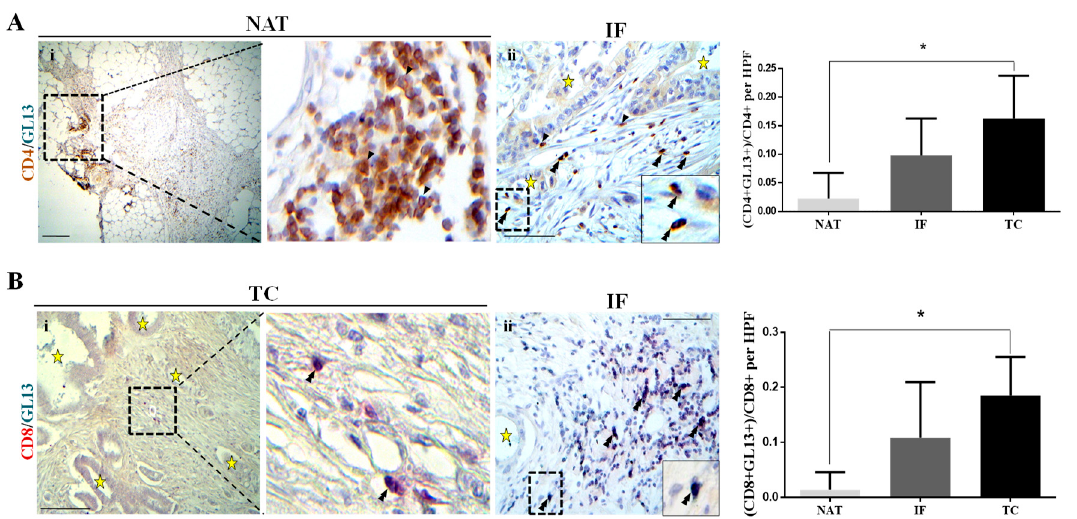
Figure 4. T lymphocytes in PDAC exhibit a senescent phenotype. ( A ) Co-expression of CD4 (brown) and GL13 (emerald) assessed by double immunohistochemistry analysis. Left panel: representative micrograph showing CD4 single positive (single arrows) in the normal parenchyma adjacent to the tumor (NAT) ( i , scale bar: 200 µ m). Insert indicates higher magnification. CD4 and GL13 double positive cells (double arrowheads) in the tumor center (TC) ( ii , scale bar: 100 µ m). Asterisks depict cancer glands. Right panel: quantification of CD4 and GL13 double positive cells per high power field (HPF, 400 × magnification). * p -value < 0.05. Data are expressed as mean ± STDEV (N = 5). ( B ) Co-expression of CD8 (red) and GL13 (emerald) assessed by double immunohistochemistry analysis. Left panel: representative micrographs of the TC ( i ) and IF ( ii ), where double arrowheads depict CD8 and GL13 double positive cells. Asterisks denote cancer glands. Scale bar: 200 µ m (i); 100 µ m (ii). Insert depicts higher magnification. Right panel: quantification of the CD8 and GL13 double positive cells per high power field (HPF, 400 × magnification). * p -value < 0.05. Data are expressed as mean ± STDEV (N = 5).